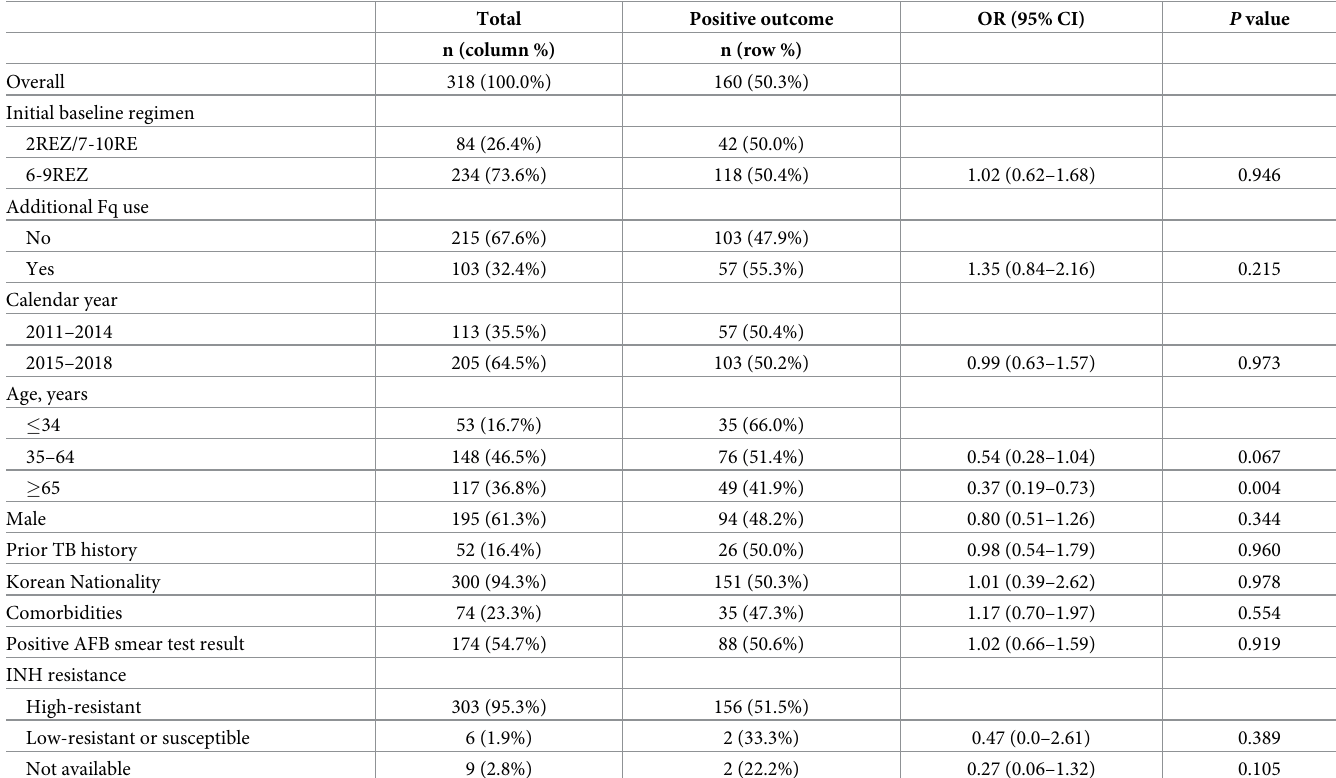
Table 3. Univariable logistic regression assessing factors associated with positive treatment